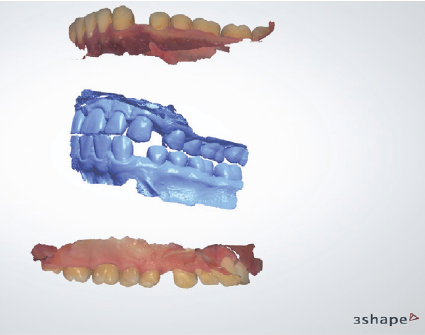
Figure 5: Intraoral digital impressions and interocclusal record.